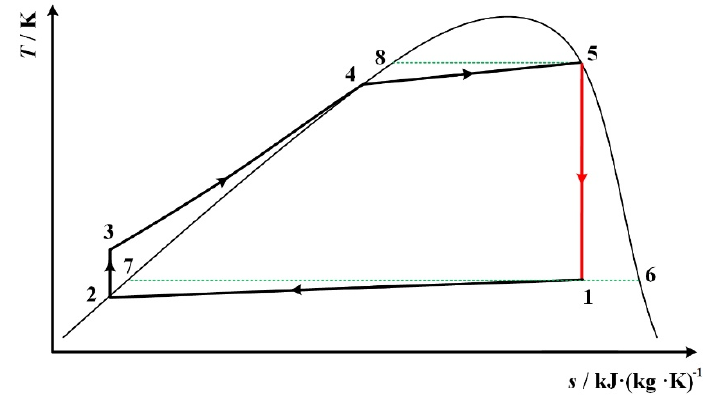
Figure 4. Subcritical ORC using single screw expander with wet zeotropic mixture as working fluid.